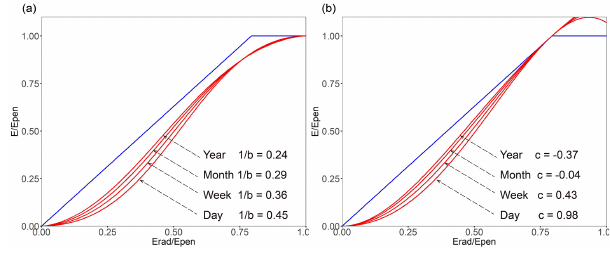
Figure 4. Plots of the SGC Eq. (1) with α = 1.26 and varying 1 /b values at multiple timescales (a) . Plots of the PGC Eq. (5) with α = 1.26 and varying c values at multiple timescales (b) . The blue lines are the P–T and Penman boundary